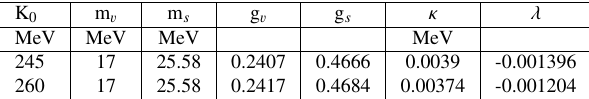
Table 1: Constrained parameter sets for equations of state with incompressibilities K 0 = 245 MeV and K 0 = 260